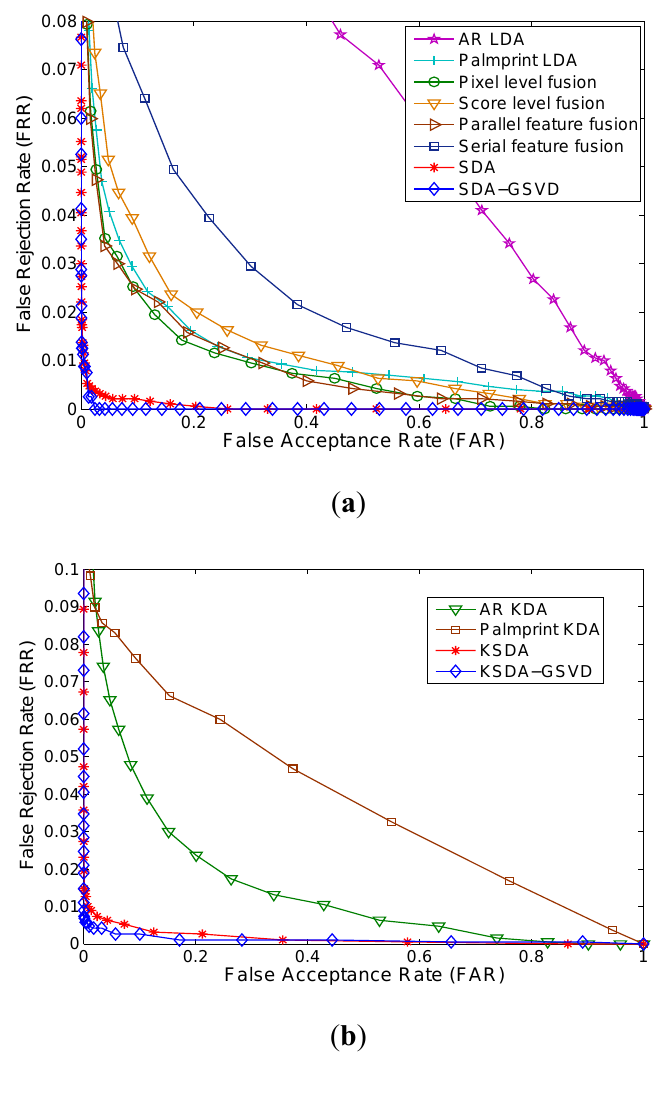
Figure 8. ROC curves of all compared methods on AR face and PolyU palmprint databases: ( a ) Linear methods; ( b ) Nonlinear